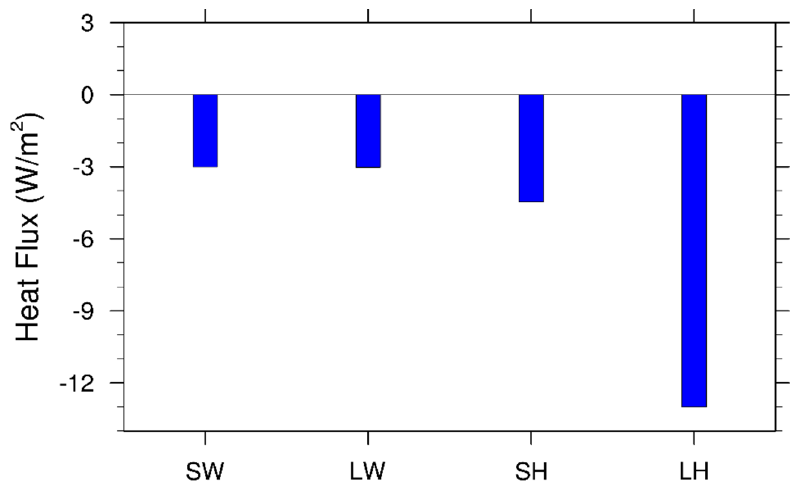
Figure 10. The average short wave radiation flux (SW), long wave radiation flux (LW), latent heat flux (LH), and sensible heat flux (SH) over the area 42°–50° N, 15°–35° W. The direction is downward for SW while it is upward for LW, LH, and SH. Unit: W/m 2 .